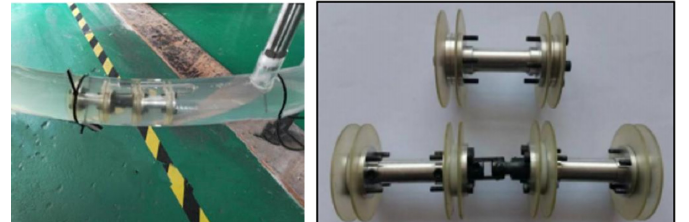
Figure 30 . Double-cabin robot model.